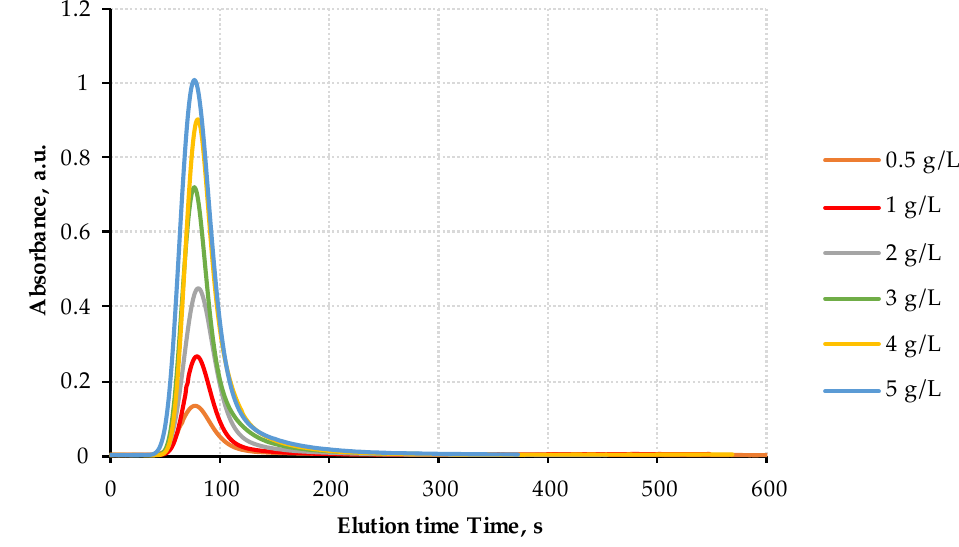
Figure 3. Chromatograms of BSA model solutions.